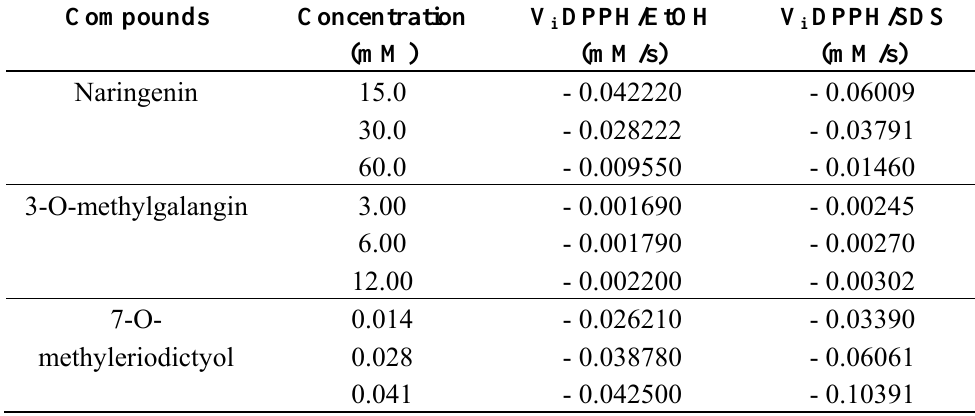
Table 1. Initial rate for the reaction of DPPH radical with the flavonoids 3 - 5 in homogenous system (EtOH) and microheterogenous system